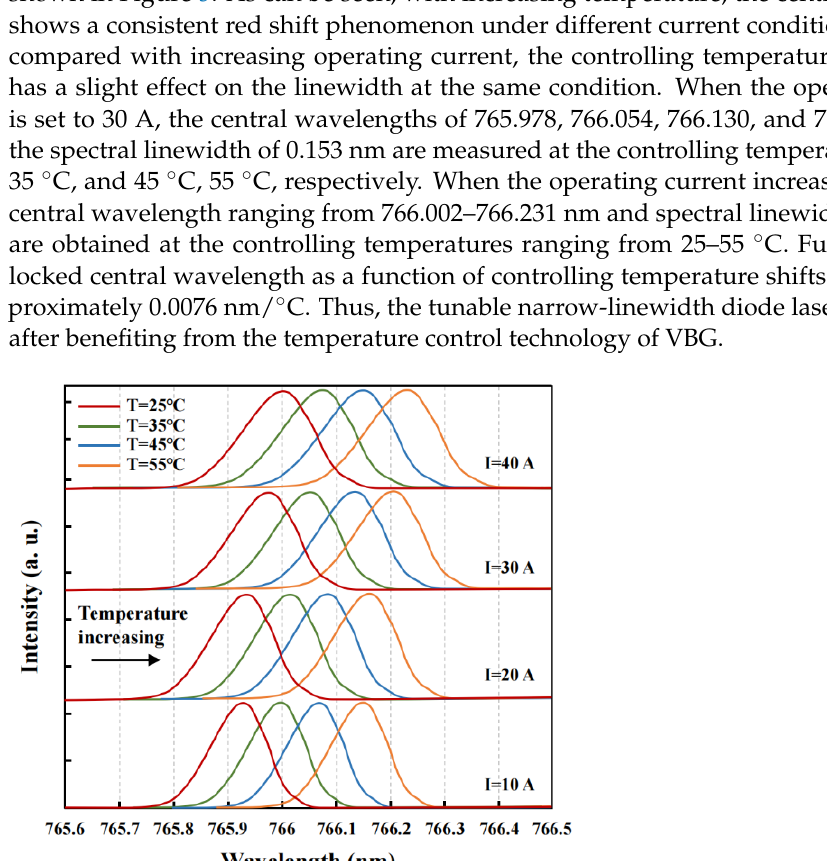
Figure 5. Tunable spectrum of locked CS lasers with increasing heating temperature at different operating currents. Finally, the external cavity feedback structure of the multiple CS lasers based on spa- tial beam combining technology is constructed for high-power laser output. In the exper- iment, the free-running, beam-combined, and external cavity feedback powers are tested,